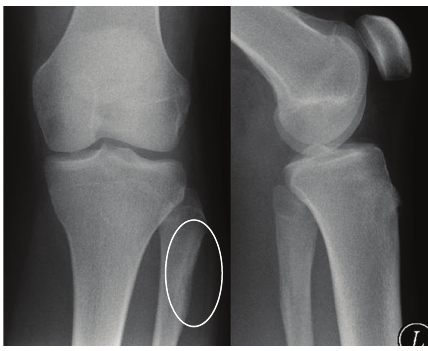
Figure 1: Preoperative X-ray showing local lucent nidus at the left proximal fibula.